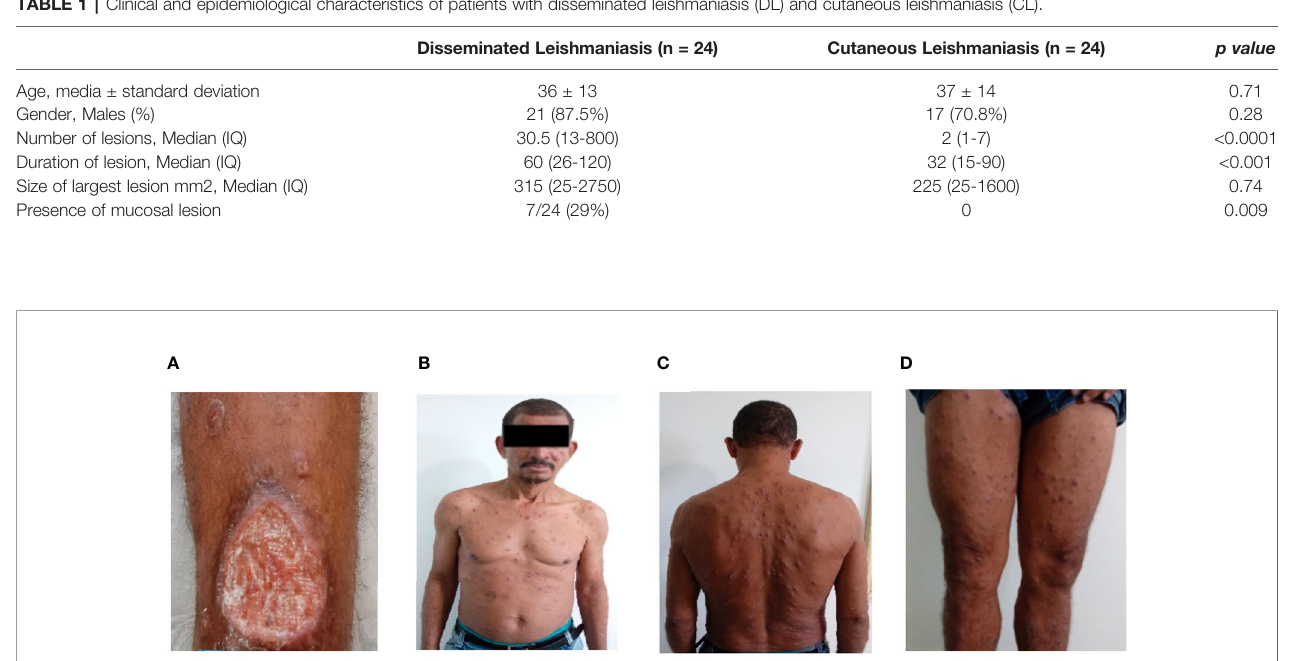
FIGURE 1 | Disseminated Leishmaniasis. Picture of a 55 years old man who initially presented an ulcer (55X45mm) in a left leg (A) . After 30 days he suddenly had fever, chills and 485 acneiform and papular lesions were documented in the face, trunk and superior and inferior limbs (B – D)